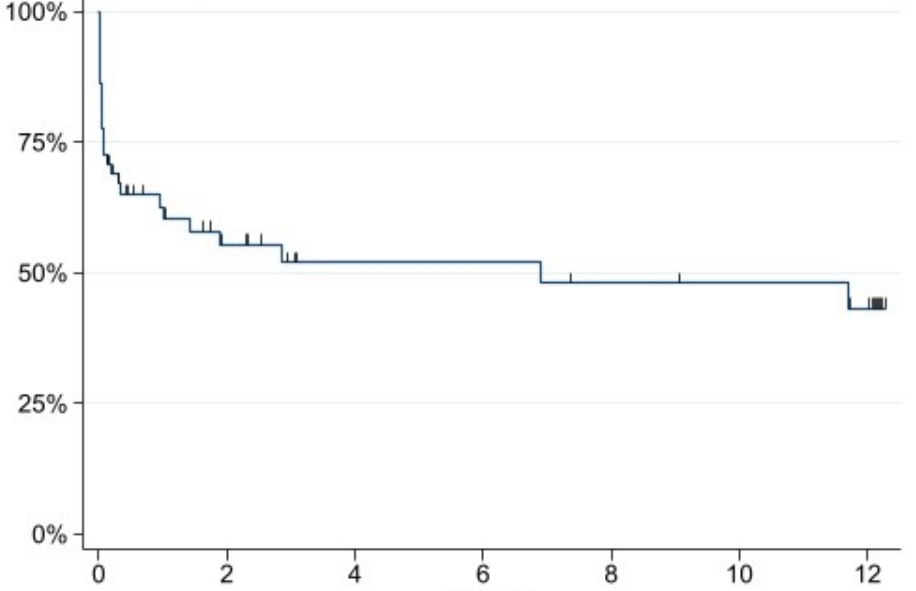
Figure 5. Kaplan–Meier mortality curve; x -axis: months; y -axis: probability of survival.